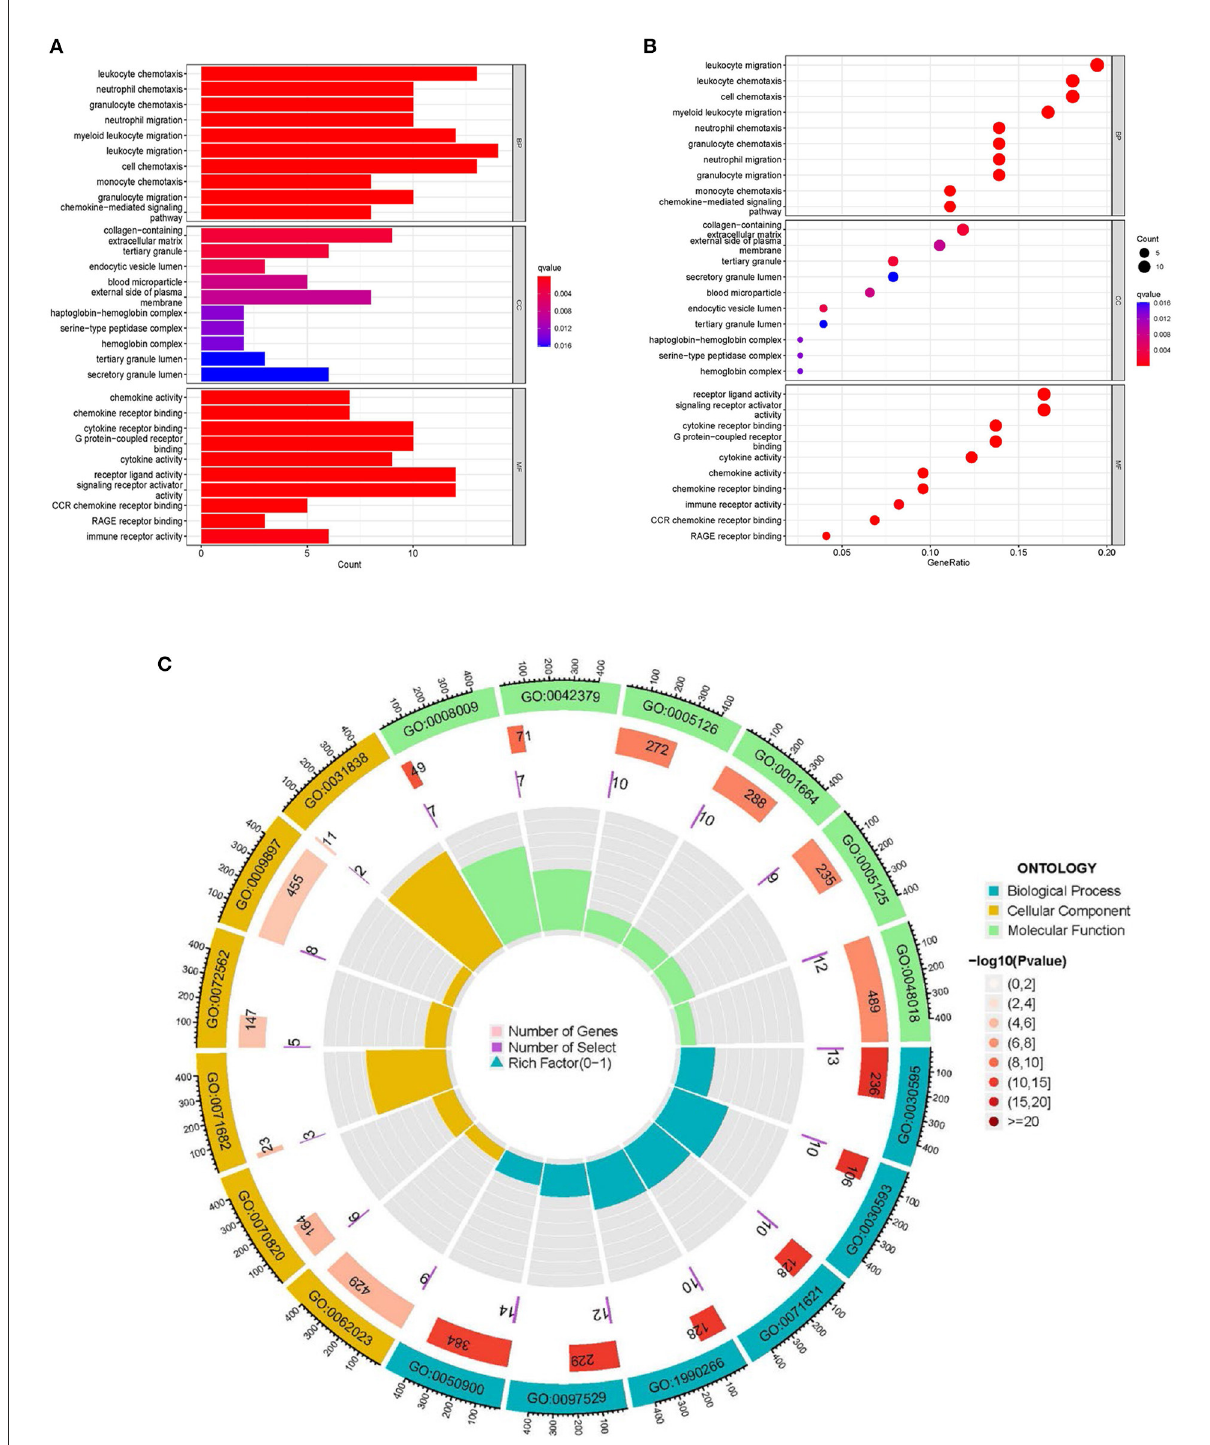
FIGURE6 GO enrichment analysis of DEGs. (A) The histogram of GO enrichment analysis; the redder the color, the more significant the enrichment. (B) Bubble diagram representing GO enrichment analysis; the size of bubbles represents the number of enriched genes, and the redder the color of the bubbles, the more significant the enrichment is. (C) The first circle indicates that BP, CC, MF are represented by different colors and the top six enriched GO:ID are taken. The second circle represents the number of genes in different GO:ID genome backgrounds, where different colors represent the significant degree of DEGs enrichment. The third circle represents the number of genes enriched by DEGs. The fourth circle represents the proportion of